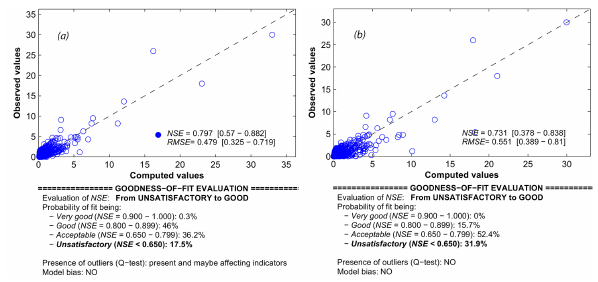
Figure 8. Goodness-of-fit evaluation for validation period (1989– 1997) at the Hunza watershed: (a) UBCANN method and (b) UBC- CLA